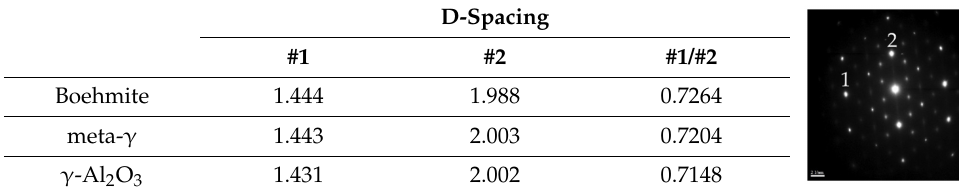
Table A1. Ratio of d values in the two directions of the cleavage plane obtained by SAED.